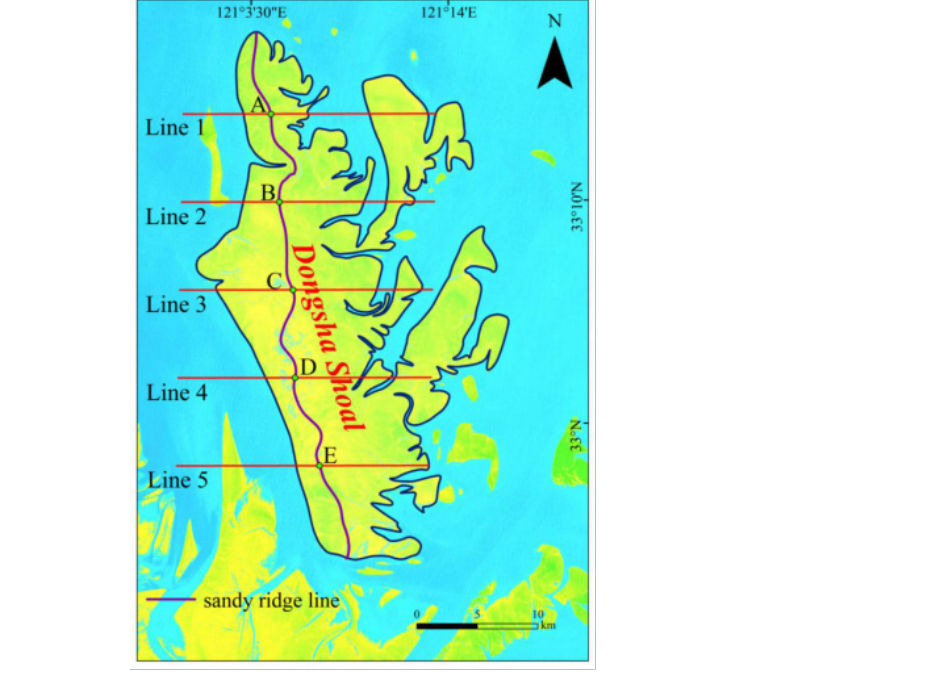
Figure 3. The location of the five typical sections and the sand ridge points formed by their intersection with the sand ridge line.